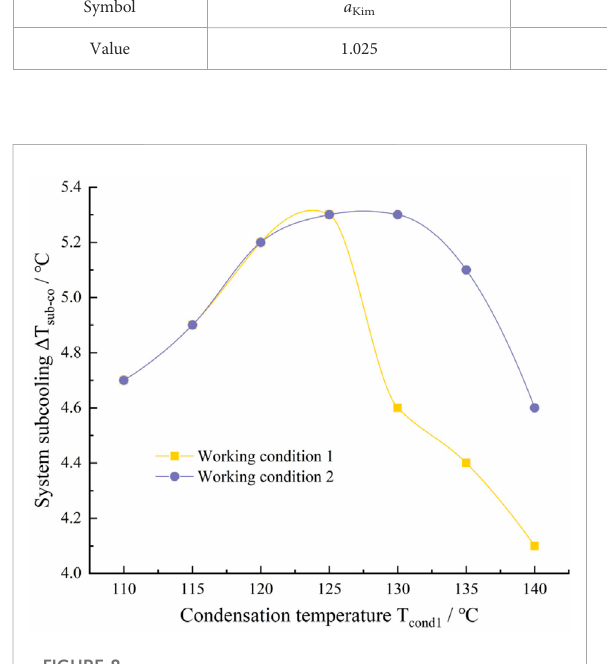
FIGURE 8 System subcooling changes under two working conditions.